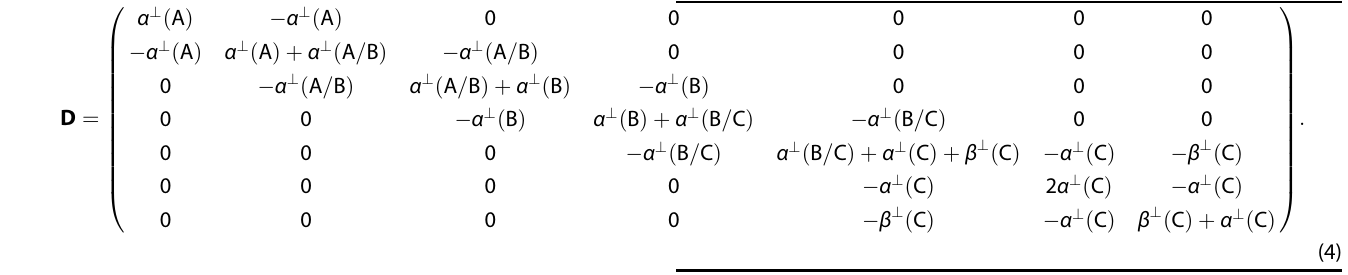
When the LCM is extended to 2L-A/2L-B/3L-C ternary vdWH, the corresponding D can be written as